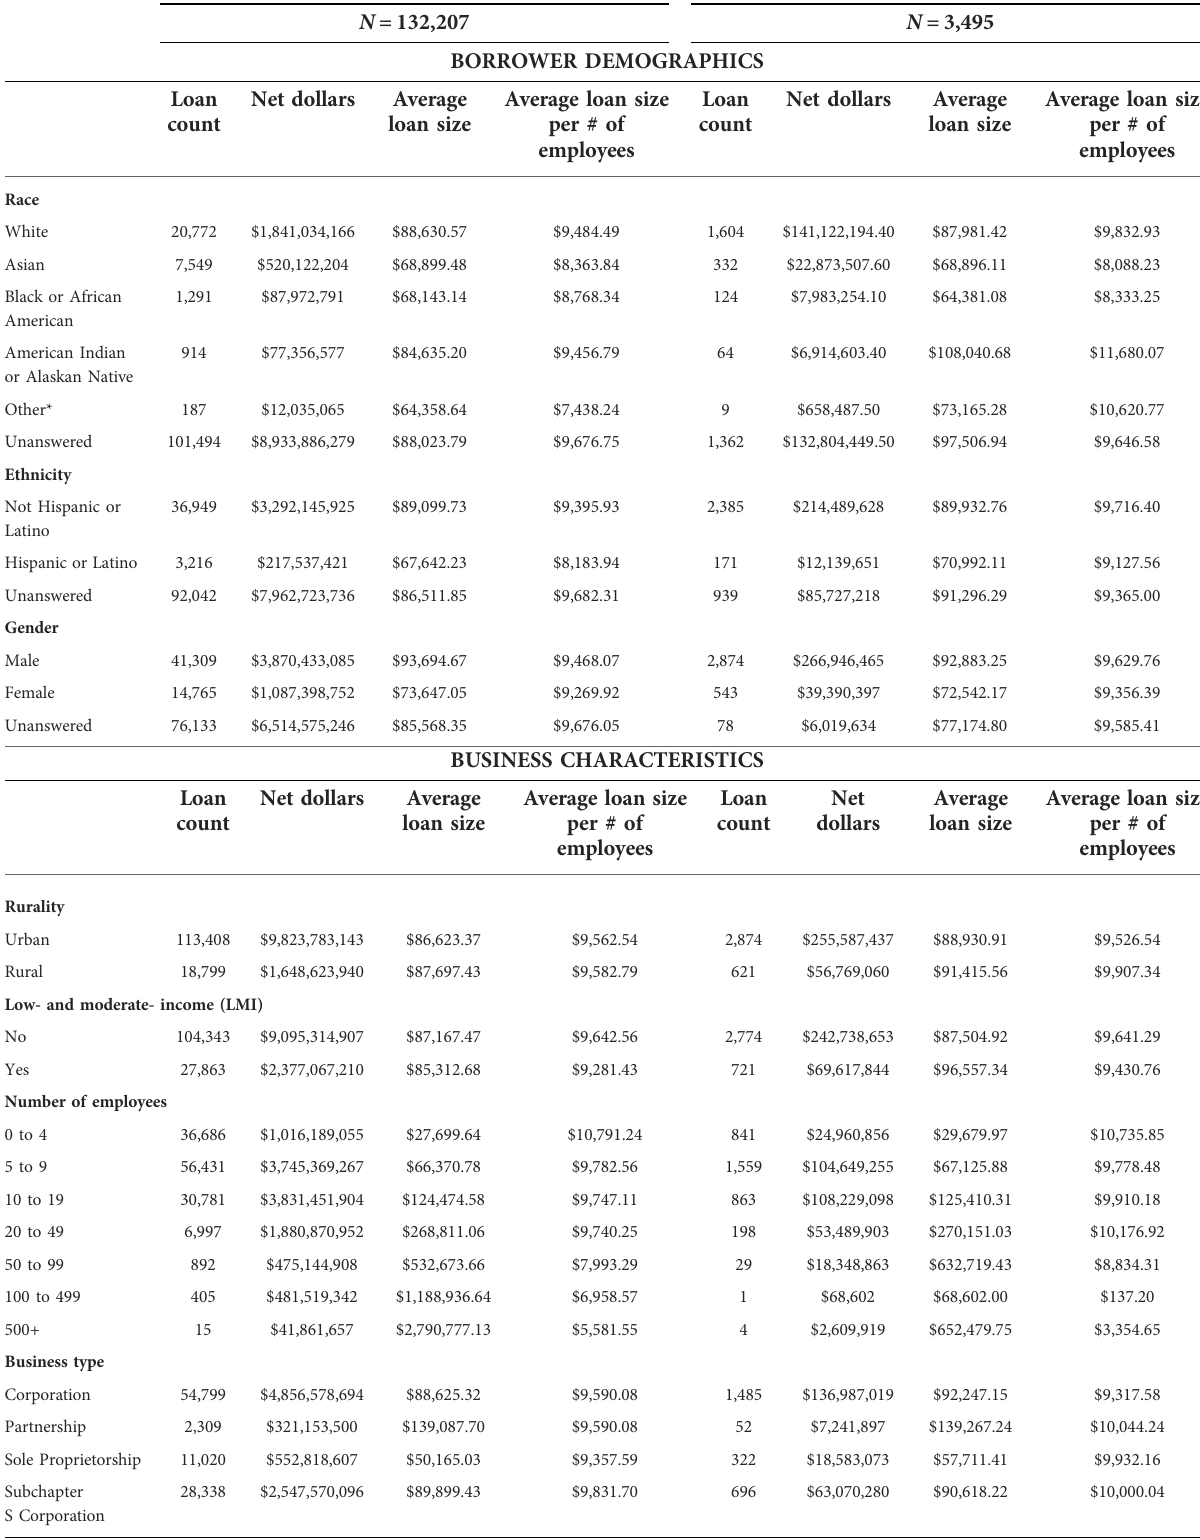
TABLE 2 Characteristics of study sample and PPP loans, based on veteran